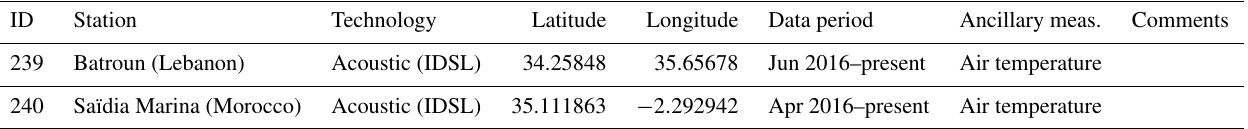
Table A27. Additional IDSL-based stations in Lebanon and